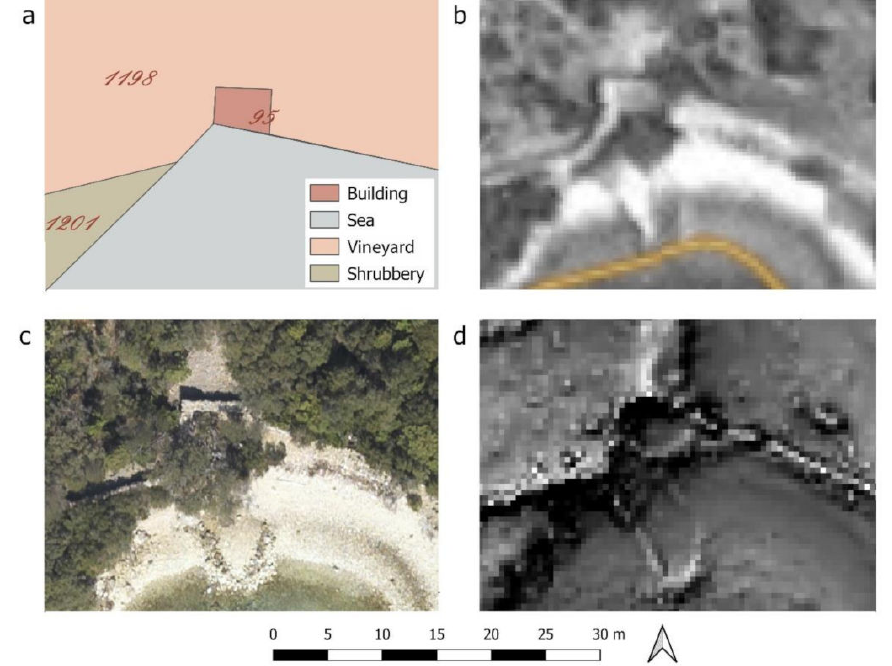
Figure 22. Remains of a